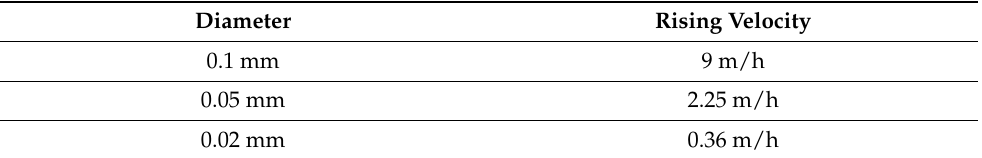
Table 1. Terminal velocity of microbubbles rising in